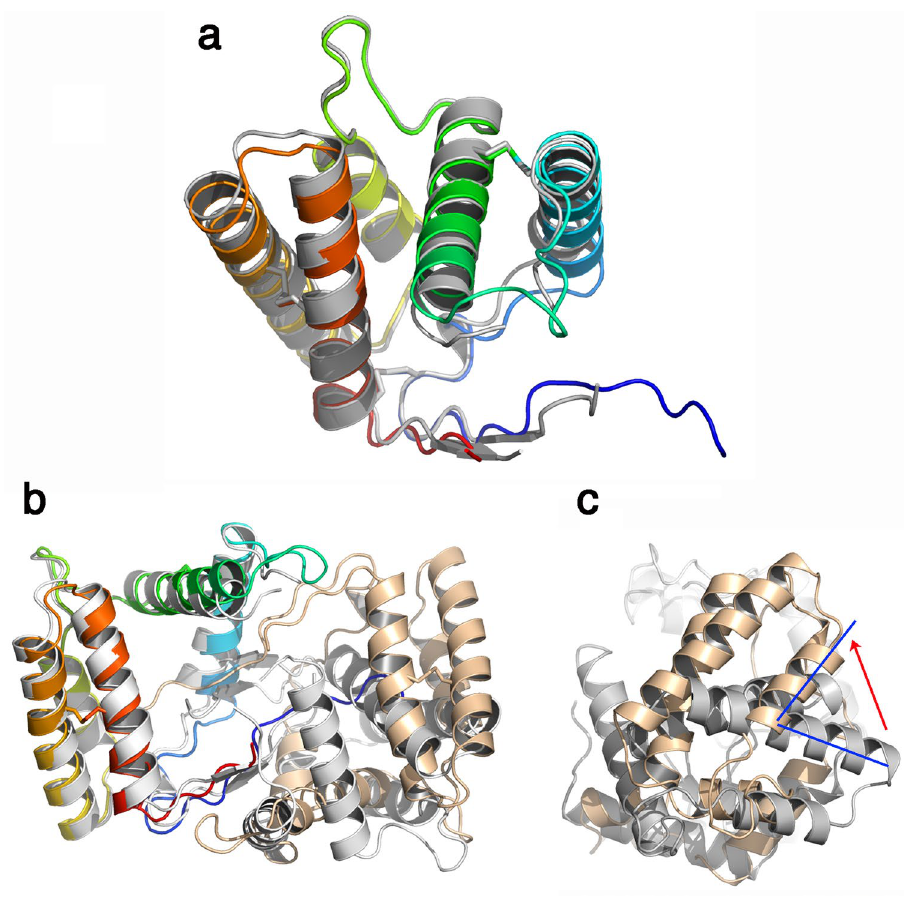
Figure 5. Comparison of crystal structures of VdesOBP1 forms P2 1 and P3 2 21. ( a ) Ribbon view of the superposition of monomers belonging to forms P2 1 (rainbow coloured) and P3 2 21 (grey). ( b ) Ribbon view of the crystallographic dimers of forms P2 1 and P3 2 21. In form P2 1 one monomer is rainbow coloured, the other one is coloured brown. The crystallographic dimer of P3 2 21 form is coloured light grey. One monomer of each form has been superimposed (left). The second monomers do not superimpose. B/same view rotated 90° around a vertical axis. Note the rotation of ~ 80° of the second monomer of form P3 2 21 relative to the second monomer of form P2 1 . Figure made with PyMOL (version 1.5.0.2. http:// www. pymol.